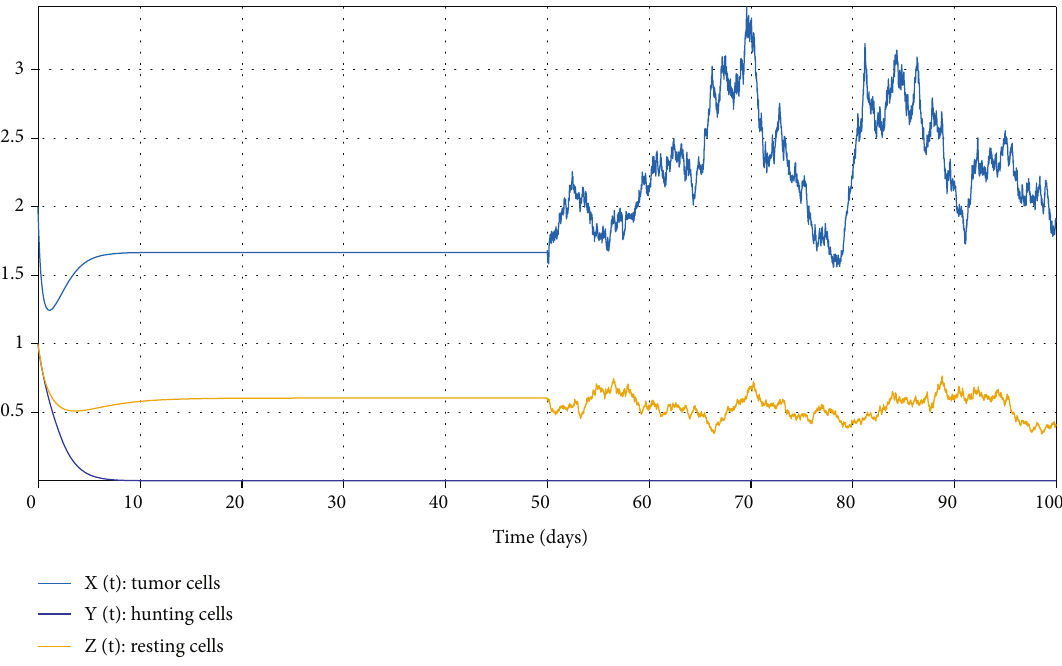
Figure 4: Time series trajectories of the piecewise systems (10) and (11) for c = 0 : 21 , c